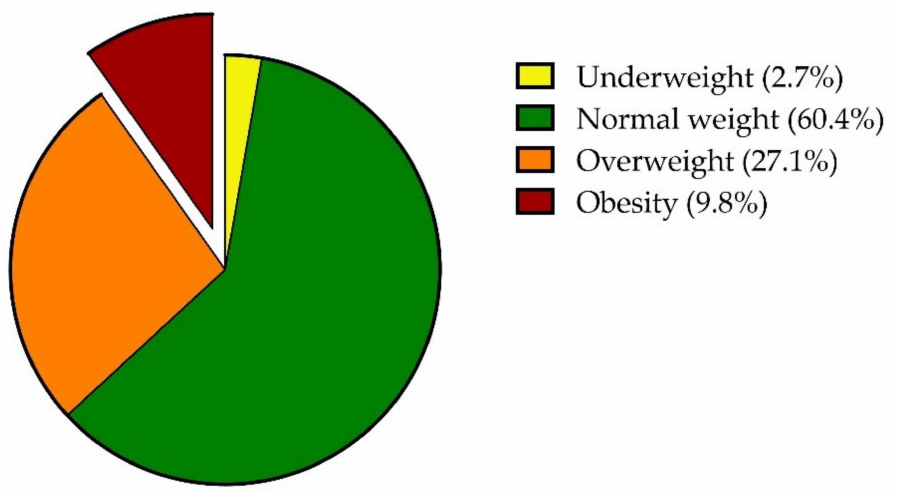
Figure 1. Proportion of participants with underweight, normal weight, overweight and obesity according to BMI values calculated using self-reported height and